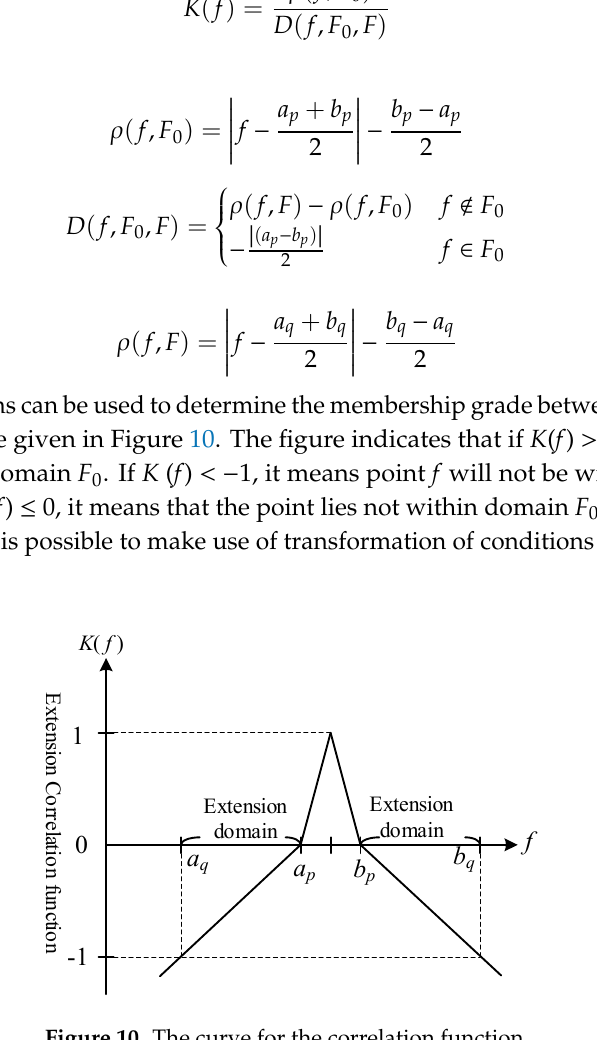
Figure 10. The curve for the correlation function .